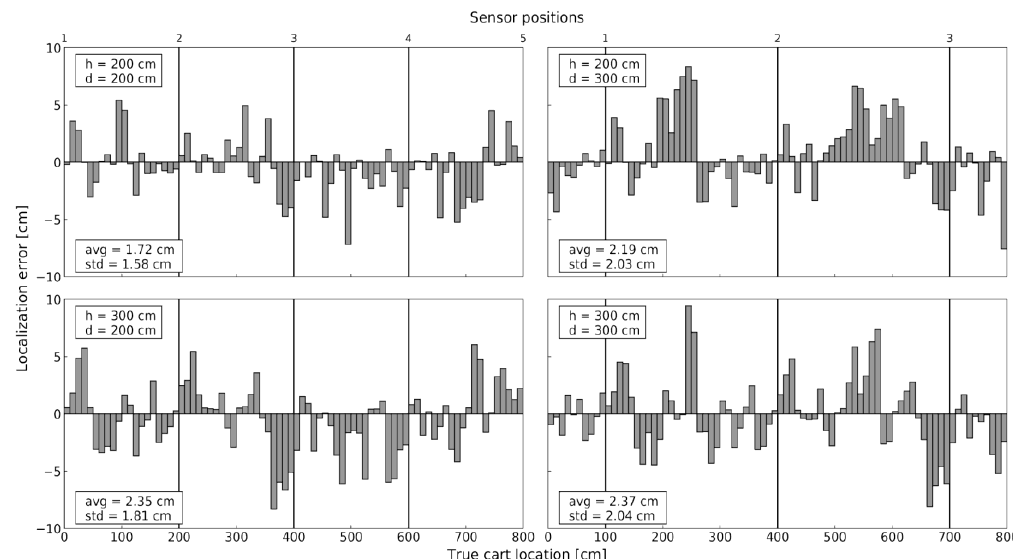
Figure 16. Localization error experimentally measured in the 8-m-long corridor for every 10 cm. Distribution of nodes with IR AoA sensor d was one in every 2 and every 3 m, left and right column, respectively. The height of the sensing nodes above the IR transmitter h was set to 2 and 3 m, top and bottom row, respectively. As can be seen from the presented results, in all scenarios, localization error did not exceed 10 cm.